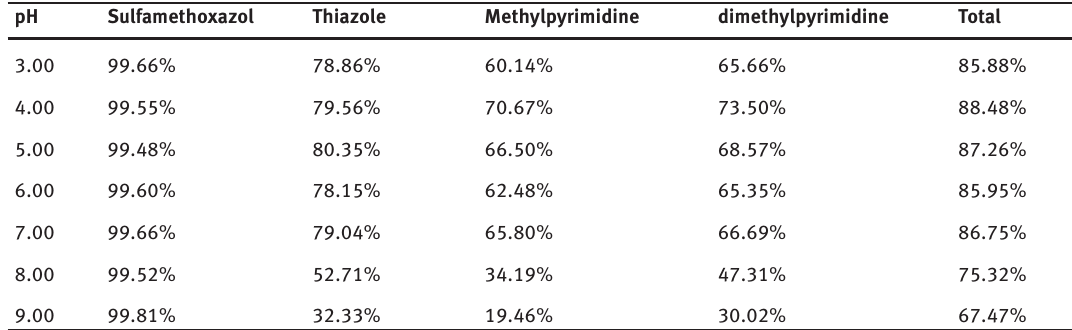
Table 2: The removal efficiency of different pollutants over biochar under different pH values. pH Sulfamethoxazol